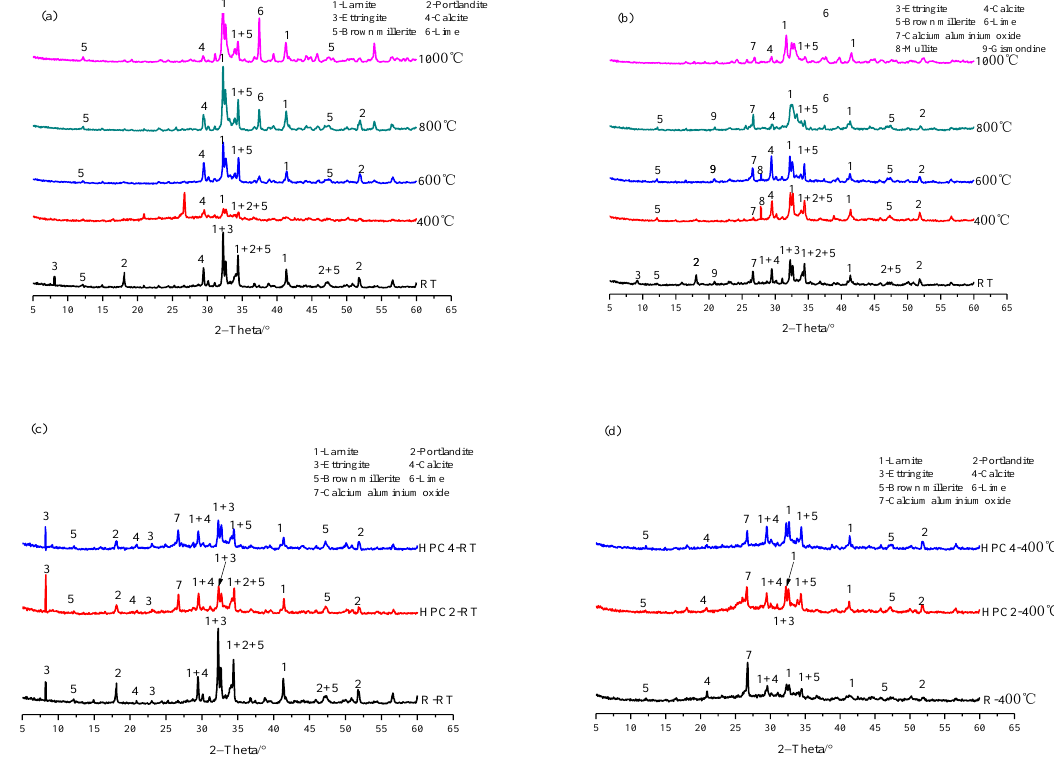
Figure 6. XRD patterns of concrete: ( a ) and ( b ) refer to the reference concrete and HPC-4 subjected to various temperatures, respectively; ( c ) and ( d ) refer to the specimens (the reference concrete, HPC-2 and HPC-4) under RT and 400 °C, respectively.